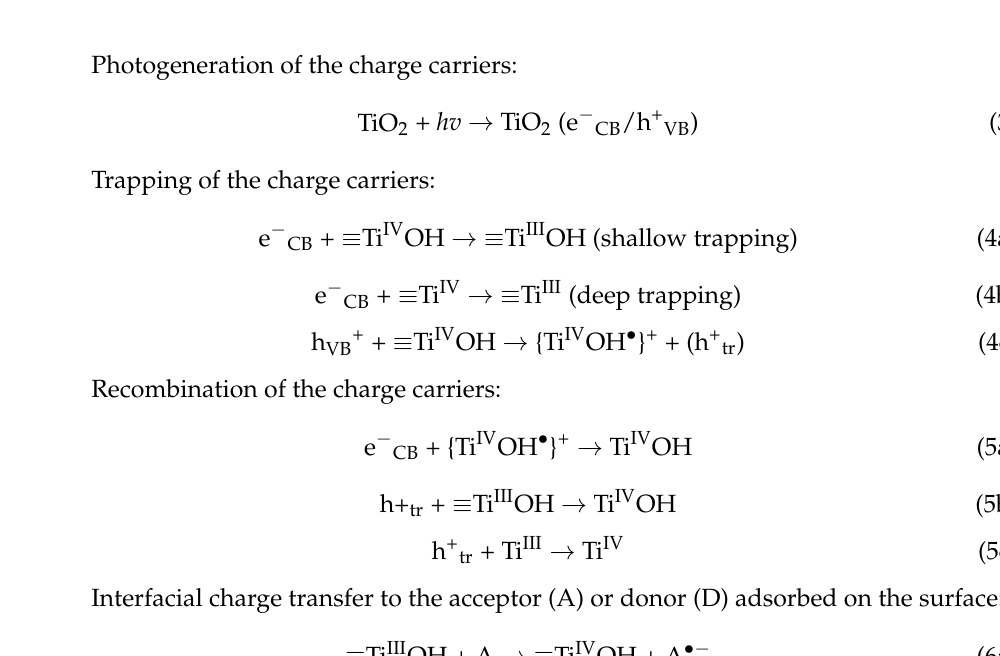
Figure 6. The possible charge carrier pathways on irradiated TiO 2 . ( a ) The possible charge carrier pathways on irradiated TiO 2 and ( b ) the time scale after irradiation for each pathway. Reprinted with permission from reference [175]. Copyright 2019 Elsevier B.V.